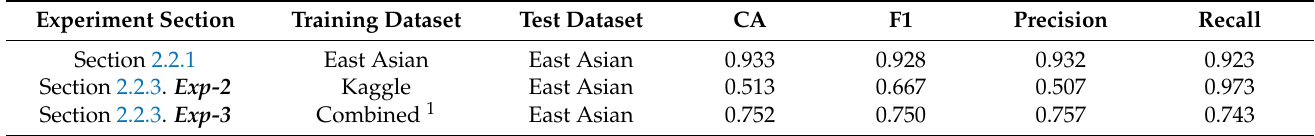
Table 12. Model performance for each of the